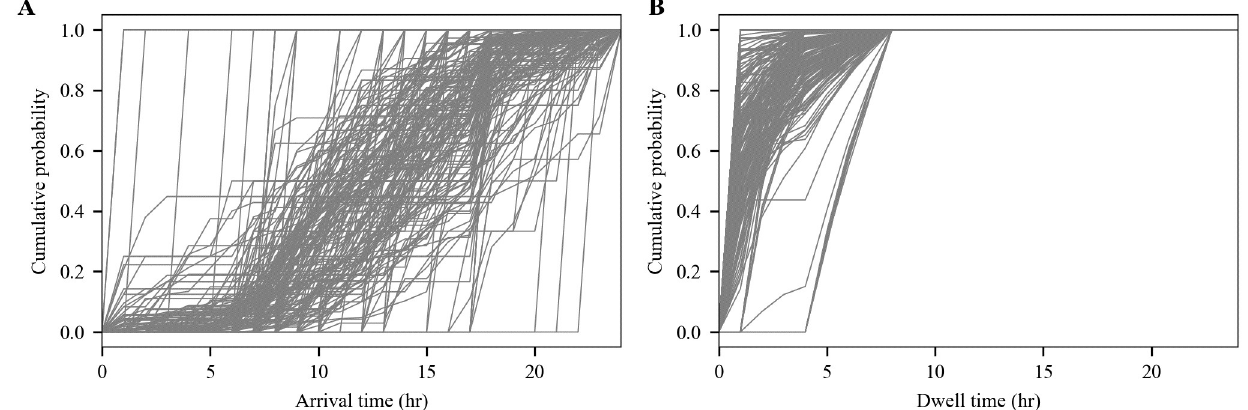
Fig 4. Arrival and dwell time distributions. Distributions include a subset of POIs in Bernalillo County. A: Arrival time. B: Dwell time. Fig 4. The sampling mechanisms are performed using 6-digit NAICS codes which, for exam-